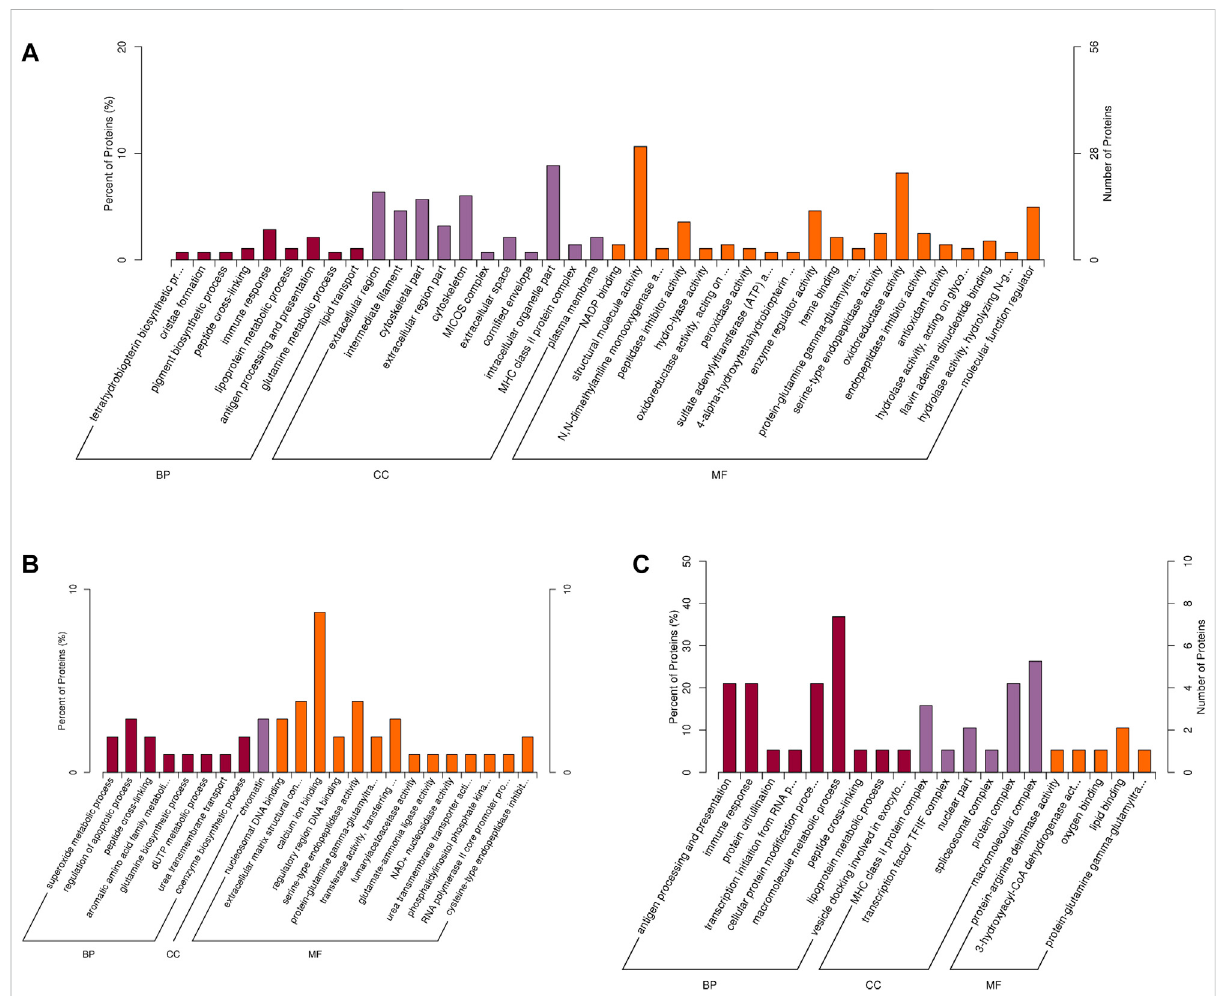
FIGURE 5 GOenrichmentanalysisofdifferentiallyabundantproteinsinrumenepitheliumbetween (A) day0andday30, (B) day30andday60,and (C) day 60 and day 90 of age. All pathways are listed according to p